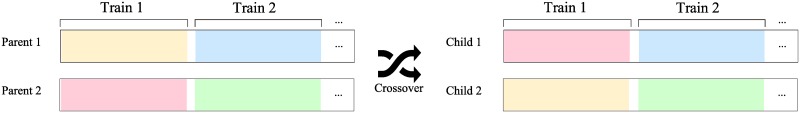
An illustration of crossover.